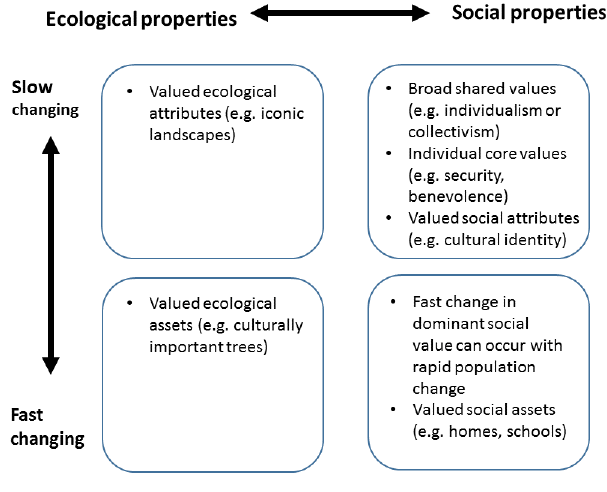
Fig. 2. Value-related components of a bushfire SES. Individual core values and broad shared values are cognitive and communicative properties of the system. Core and shared values normally change slowly, but dominant values can change fast at a local level where rapid population change occurs. Core values are applied to ecological and social properties of the system through a valuing process, resulting in valued attributes and entities of the system (Rawluk et al.